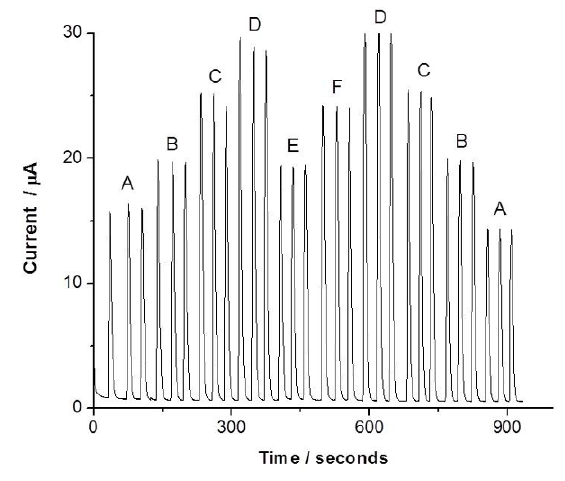
Figure 3. Peaks recorded for standard ETB and synthetic urine solutions: 0.5 mmol L -1 (A); 0.7 mmol L -1 (B); 0.9 mmol L -1